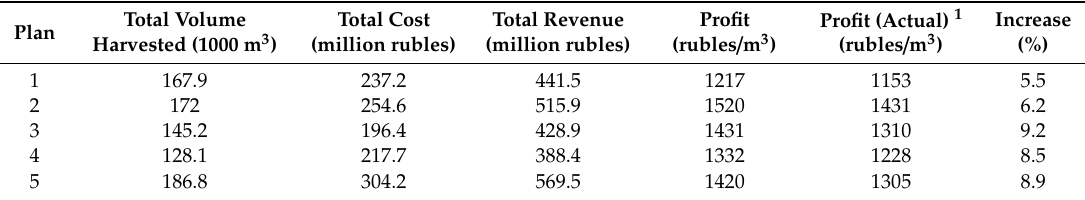
Table 1. Plan calculation results.